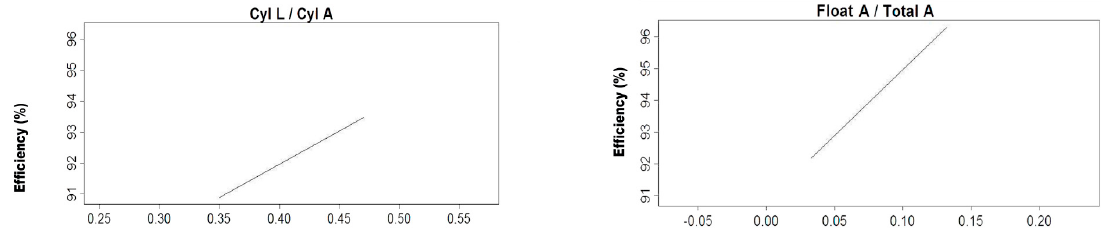
Figure 4. Graphical representation of the basis functions of MARS model number two and their coefficients for feed with media.